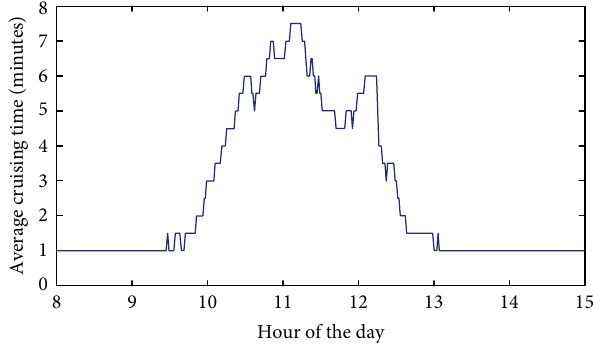
Figure 8: Average cruising time for on-street parking over a typical working day.